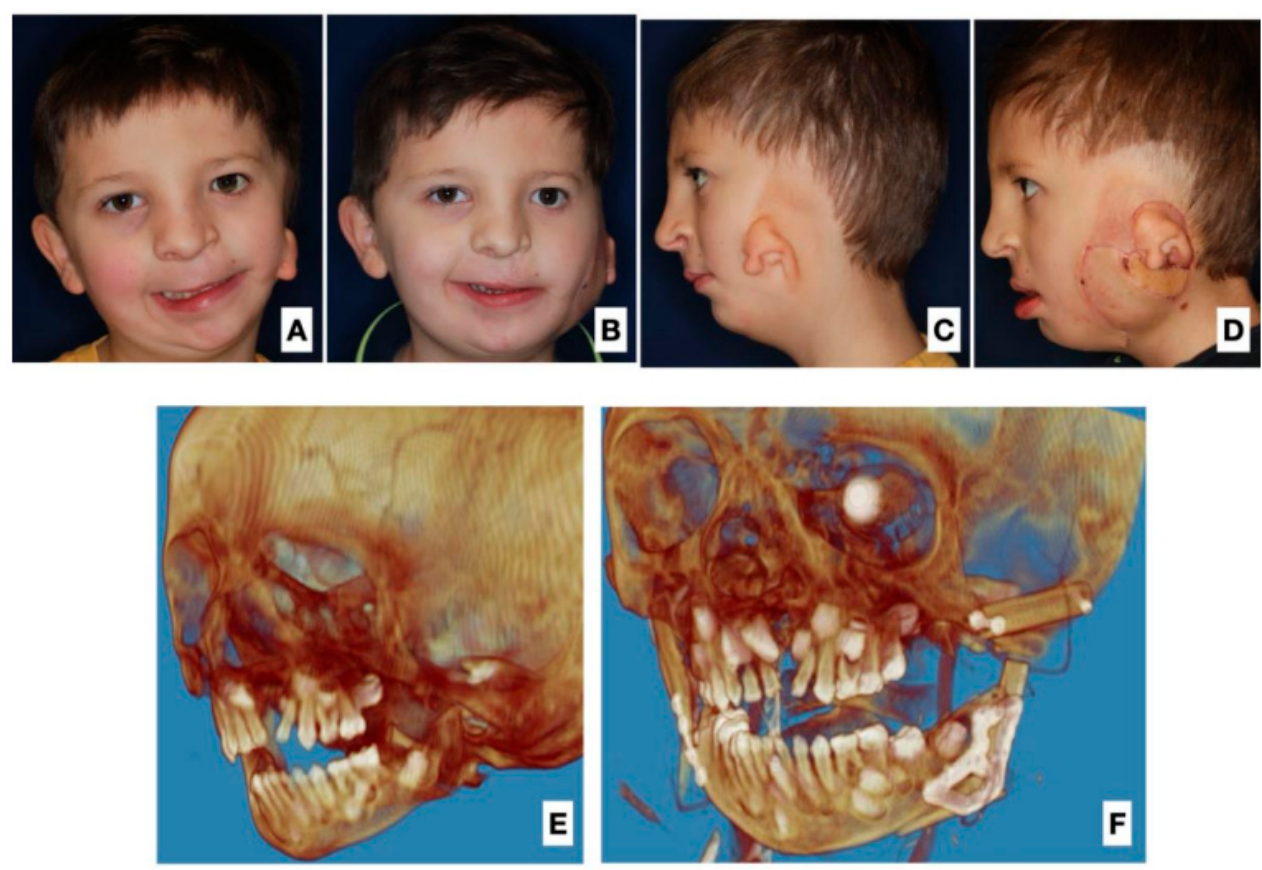
Figure 2. ( A ) Frontal view before surgery, showing asymmetry and soft tissue deficit. ( B ) View one month after surgery with visible correction of asymmetry and soft tissue deficit. ( C ) Side view before surgery. ( D ) Side view one month after surgery, visible insertion in cheek area. ( E ) Preoperative 3D image reconstruction. ( F ) 3D image reconstruction after surgery and mandibular FFF reconstruction. Table 2. Characteristics of free flaps used for mandibular reconstruction in patients with HFM with definition of the affected side, number of bony elements of the fibular flap, collection of the skin island, reconstruction of the mandibular anatomical region, use of additional osteotomies during mandibular reconstruction with a free flap based on microvascular anastomoses, occurrence of complications during and after surgery, use of virtual planning and individual implants (VSP, IPS), follow-up period after reconstruction. CCG—costochondral graft, FFF—free fibula flap.